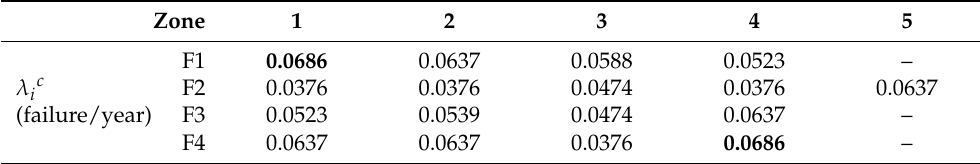
Table 5. Failure rate per zone obtained through the correlated method. Zone